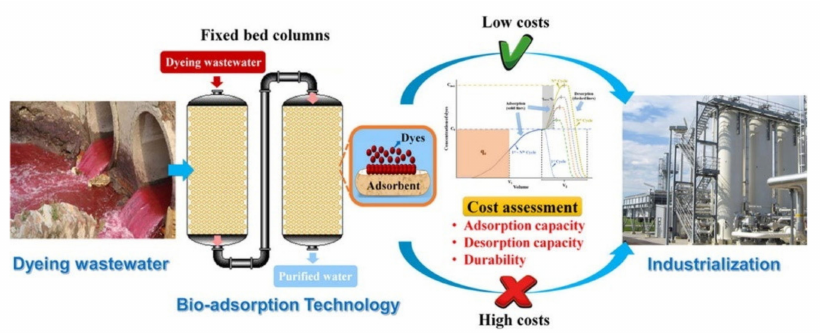
Figure 6. Adsorption of dyeing wastewater [85], with permission from